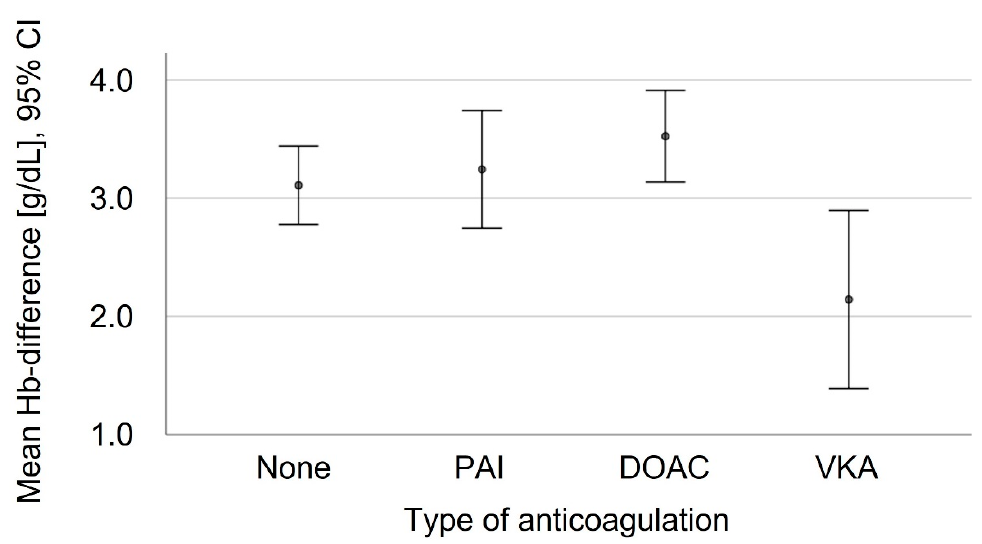
Figure 5. Mean postoperative Hb difference [g/dL] depending on different type of anticoagulation. Logistic regression showed only an increased risk for a higher Hb difference for patients taking DOAC. PAI: Platelet aggregation inhibitors including acetylsalicylic acid; DOAC: Direct oral anticoagulants; VKA: Vitamin-K-antagonist Warfarin.